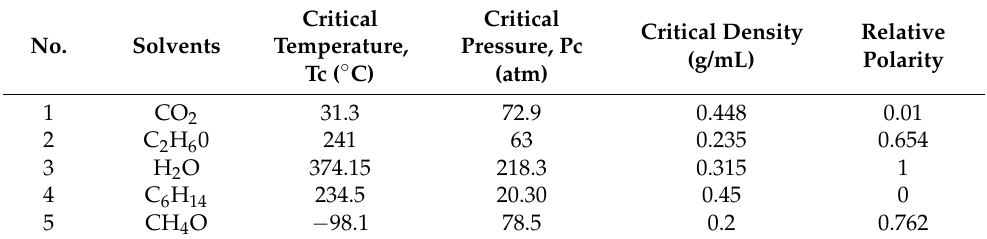
Table 3. Critical temperature and pressure of solvents.